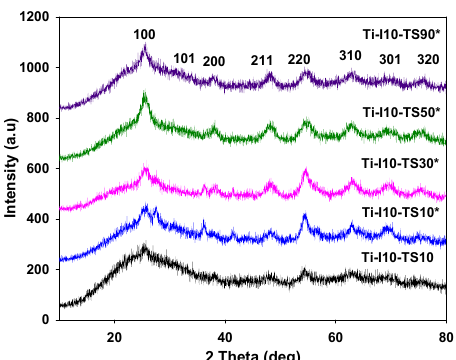
Figure 4. Wide angle XRD patterns for the Ti-I10-TS10 & Ti-I10-TSx* samples (x = 10, 30, 50, 90). J. Compos. Sci. 2019 , 3 , x